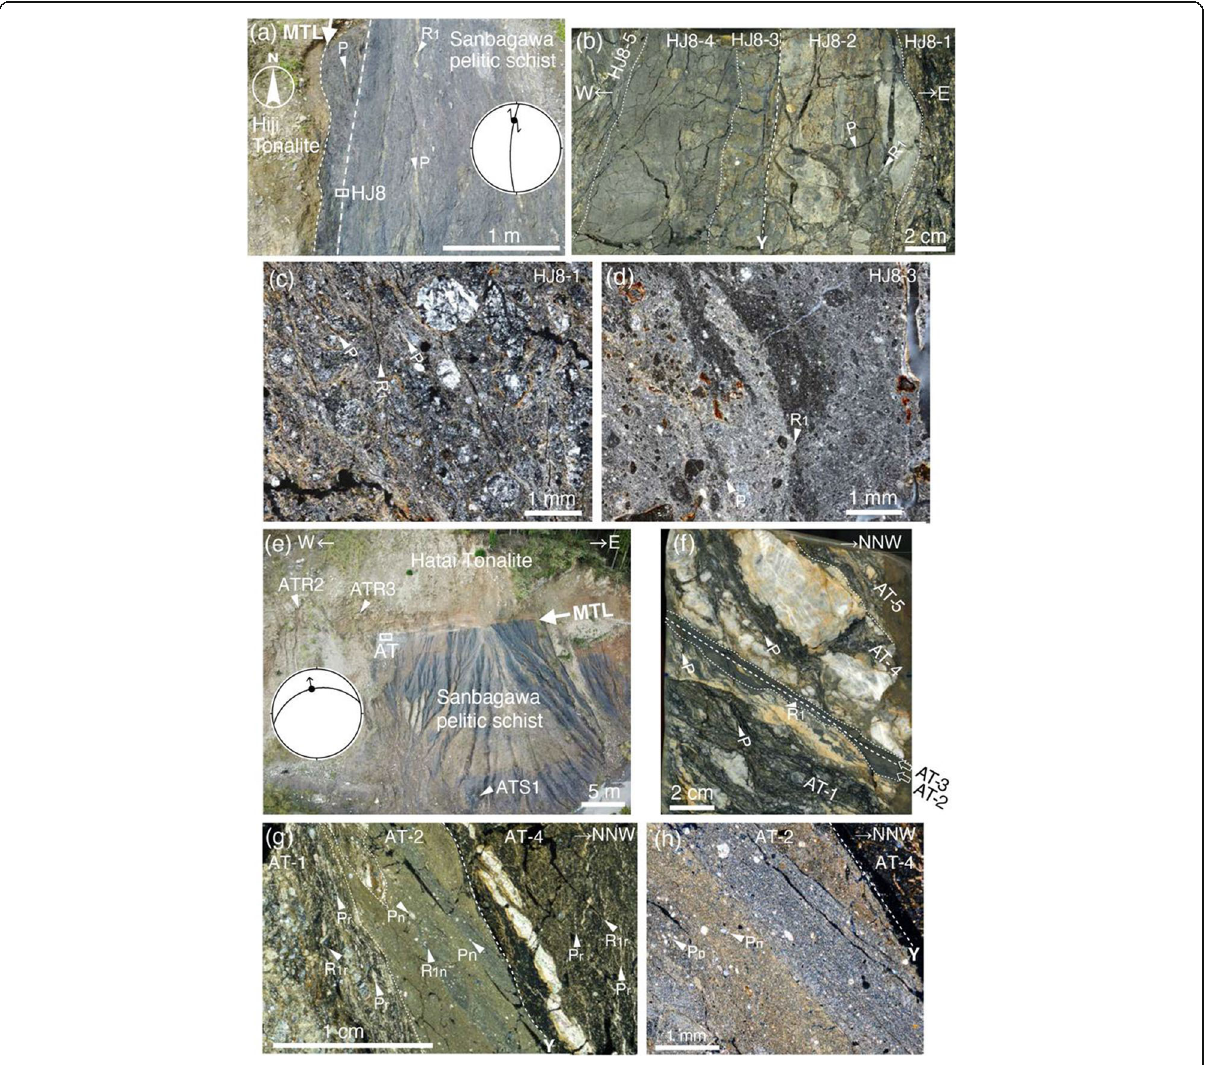
Fig. 3 Photographs of the outcrop ( a , e ), and polished slab ( b , f ) of the observed brittle fault rocks taken perpendicular to the fault plane and parallel to the lineations, and photomicrographs ( c , d , g , h ; cross-polarized light) of the fault rock samples. a The Hiji outcrop of the MTL. b HJ8. c HJ8-1. d HJ8-3. e The Awano – Tabiki outcrop of the MTL. f AT. g AT-1 – AT-2 – AT-4. h AT-2 – AT-4. The stereoplots show the orientation of fault plane Y and the direction of slip in the zone formed during the most recent fault movements ( a , e ). Abbreviations in ( g ) and ( h ): P : P foliation; R shear; P n , P r : P foliations showing normal and reverse senses of shear, respectively; R 1n , R 1r : Riedel shear showing normal and reverse senses of shear,